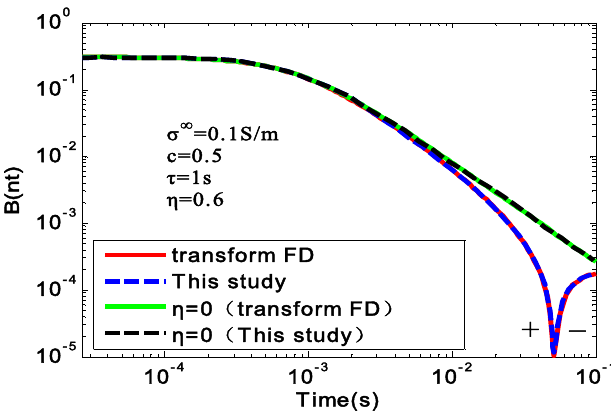
Figure 3. The response curve of the half-space model.